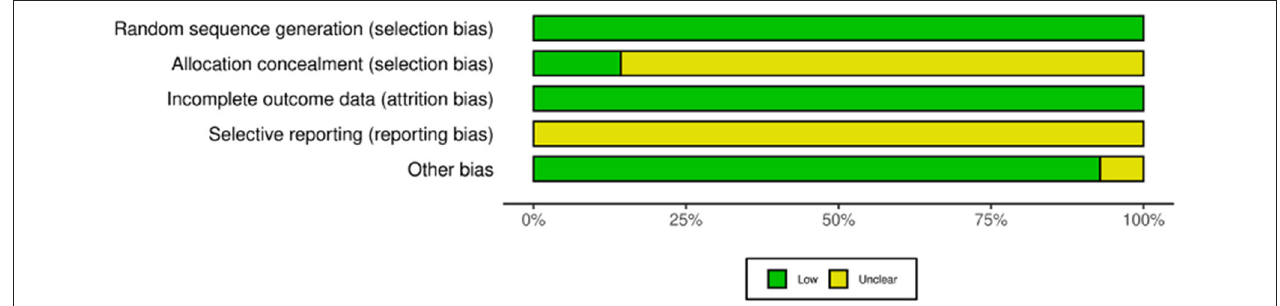
FIGURE 4 | Risk of bias for the included